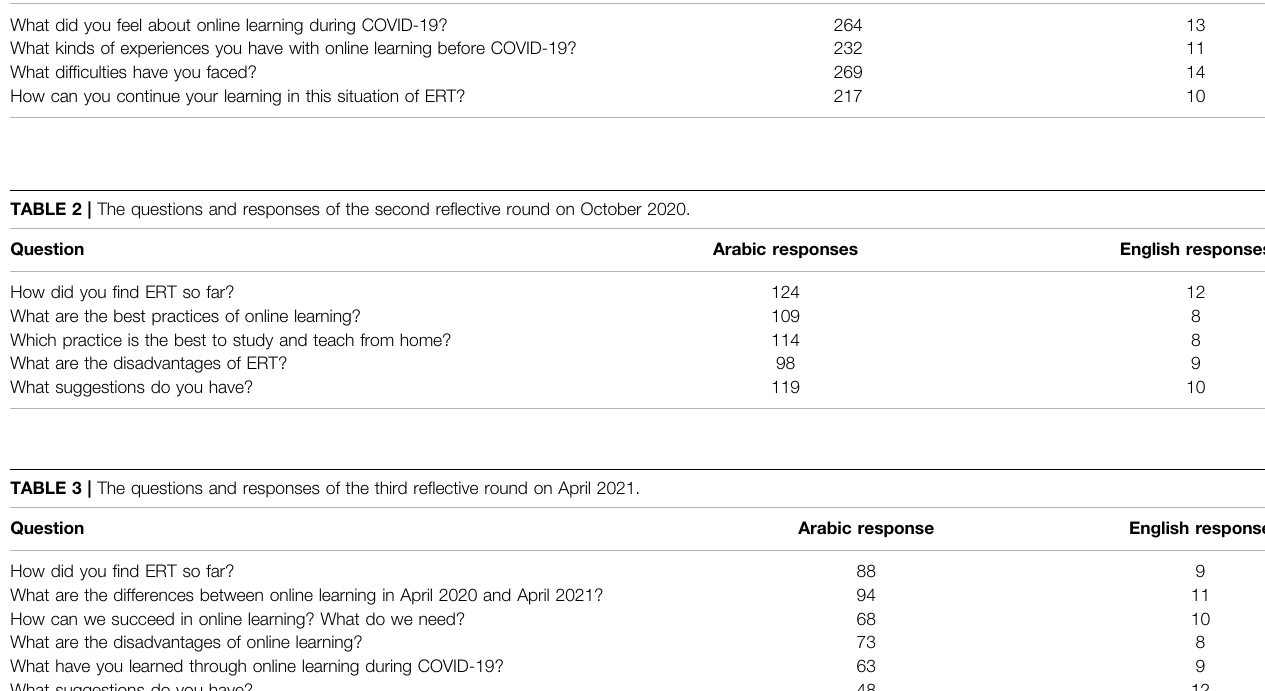
TABLE 1 | The questions and responses of the fi rst re fl ective round on April 2020. Question